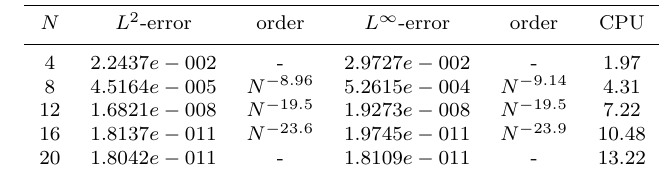
Table 2. Spatial convergence rates at t = 2 for Example 1. N L 2 -error order L ∞ -error order CPU 4 2 . 2437 e − 002 - 2 . 9727 e − 002 - 1 . 97 8 4 . 5164 e − 005 N − 8 . 96 5 . 2615 e − 004 N − 9 . 14 4 . 31 12 1 . 6821 e − 008 N − 19 . 5 1 . 9273 e − 008 N − 19 . 5 7 . 22 16